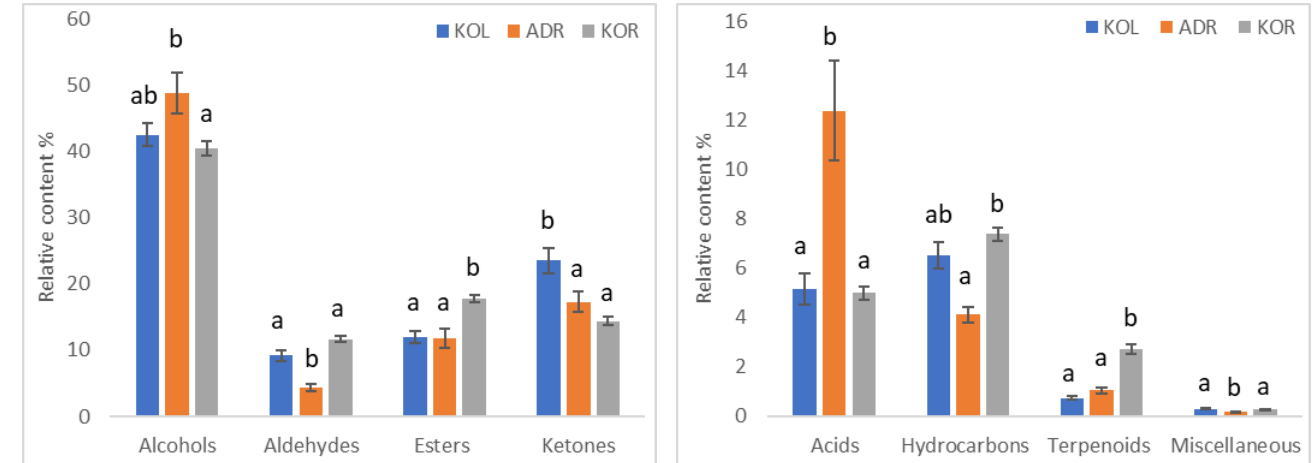
Figure 2. Comparison of the relative content (%) of the chemical classes of volatile compounds iden- tified in EVOOs originated from various cultivars. KOL: Kolovi; ADR: Adramytini; KOR: Koroneiki. The error bars indicate standard errors at 95% confidence level. Data in the same class with different lowercase letters differ significantly ( p < 0.05).